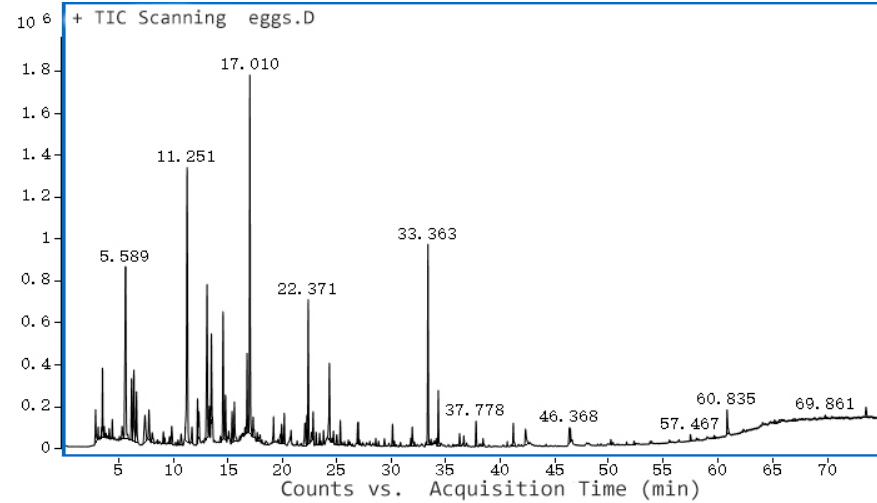
Figure 6. GC-MS of volatile compounds of fresh egg yolk.